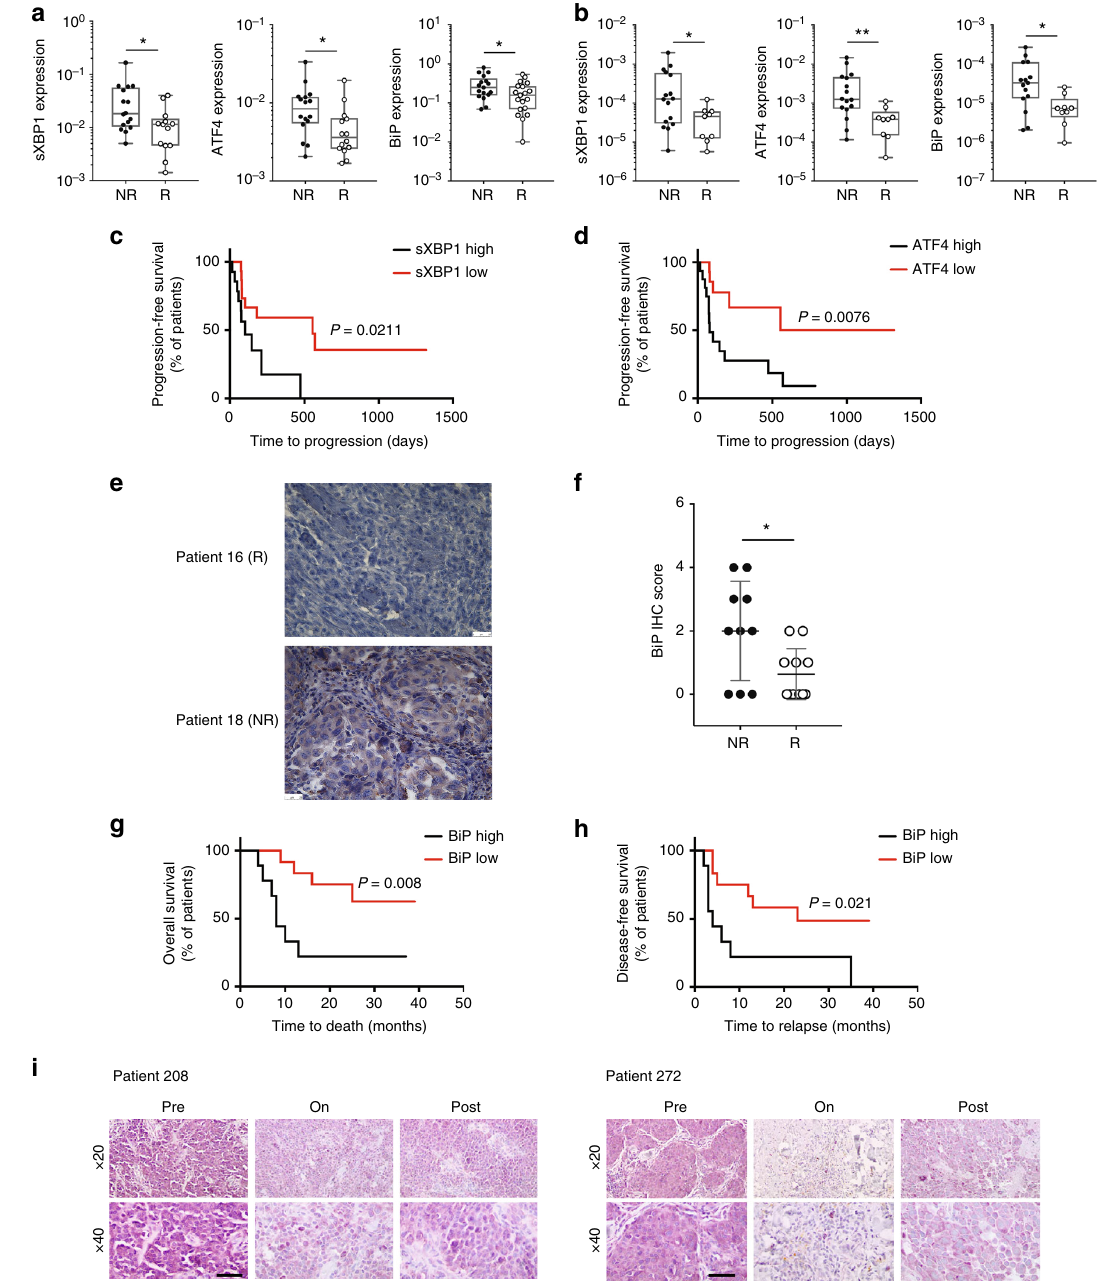
Fig. 7 Altered UPR in melanoma responders of anti-CTLA-4 immune therapy. a Analysis of ER stress markers genes in non-responders (NR) ( n = 16) and responders (R) ( n = 14) to immune checkpoint therapy in melanoma samples from MGH/DFCC (USA). b Analysis of ER stress markers genes in NR ( n = 16) and R ( n = 9) to anti-CTLA-4 immunotherapy in melanoma samples from Zurich Hospital (Switzerland). c Kaplan – Meier curves for progression-free survival probability in melanoma patients demonstrating low ( n = 15 patients) versus high sXBP1( n = 14 patients) in tumor specimens obtained before immune checkpoint therapy at MGH/DFCC. d Kaplan – Meier estimates of progression-free survival probability in melanoma patients demonstrating low ( n = 14 patients) versus high ATF4 ( n = 16 patients) in tumor specimens obtained before immune checkpoint therapy in melanoma samples at MGH/ DFCC. e Representative micrographs of IHC staining of BiP after anti-PD-1 immunotherapy in melanoma samples obtained at Rambam Health Care Center (Israel) (scale bar = 25 μ m). f IHC score of BiP staining in NR ( n = 10) and R ( n = 11) to anti-PD-1 immunotherapy in melanoma samples from Rambam Health Care Center (Israel). g , h Kaplan – Meier estimates of ( g ) overall survival and ( h ) disease-free survival probability in melanoma patients demonstrating low (<25%, n = 12 patients) versus high melanoma cell expression of BiP (>25%, n = 9 patients) in tumor biospecimens obtained before initiation of systemic anti-PD-1 antibody treatment in melanoma samples from Rambam Health Care Center (Israel). i IHC staining of BiP in melanoma samples from select patients prior to, on and after immunotherapy treatment from MGH/DFCC (USA). Scale bar = 50 μ m. Graphs show the mean ± s.e.m. * P < 0.05, ** P < 0.005, *** P < 0.001, **** P < 0.0001 by two-tailed t- test or Mann – Whitney U test ( a , b , f ) or log-rank test ( c , d , g , h